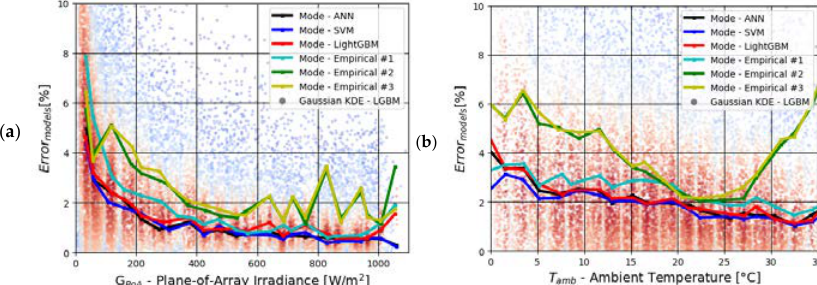
Figure 5. Mode of the standard error per cluster of ( a ) PoA irradiance and ( b ) ambient temperature for each model. Coloured dots illustrate as an example of the Gaussian distribution of the Light Gradient Boosting Machine (LightGBM) model per cluster.